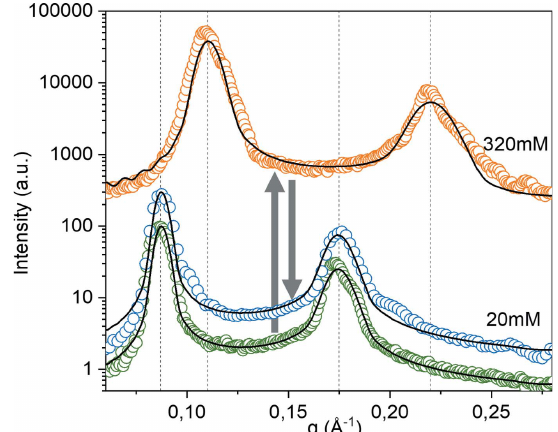
Figure 4 pH-dependent phase transition in an amphiphilic peptide mesophase. Left: time-resolved in-house SAXS measurement (background corrected) of in situ dialysis with 3D-printed dialysis chamber from pH 7.5 to pH 4.7 of IDPAs shows a transition from micellar rods to spherical micelles in less than 6 h. Scattering curves are snapshots at 0, 140, 160, 180 and 220 min with 20 min exposure time each. Solid lines are convoluted reference scattering curves from high-resolution SAXS beamlines (data were taken with an automated sample robot at DESY, Hamburg, Germany). Right: pH-dialysis back from pH 4.7 to pH 7.5 shows the reversibility of the transition in the dialysis chamber. Scattering curves are snapshots at 0, 260, 240, 340 and 520 min with 20 min exposure time each.